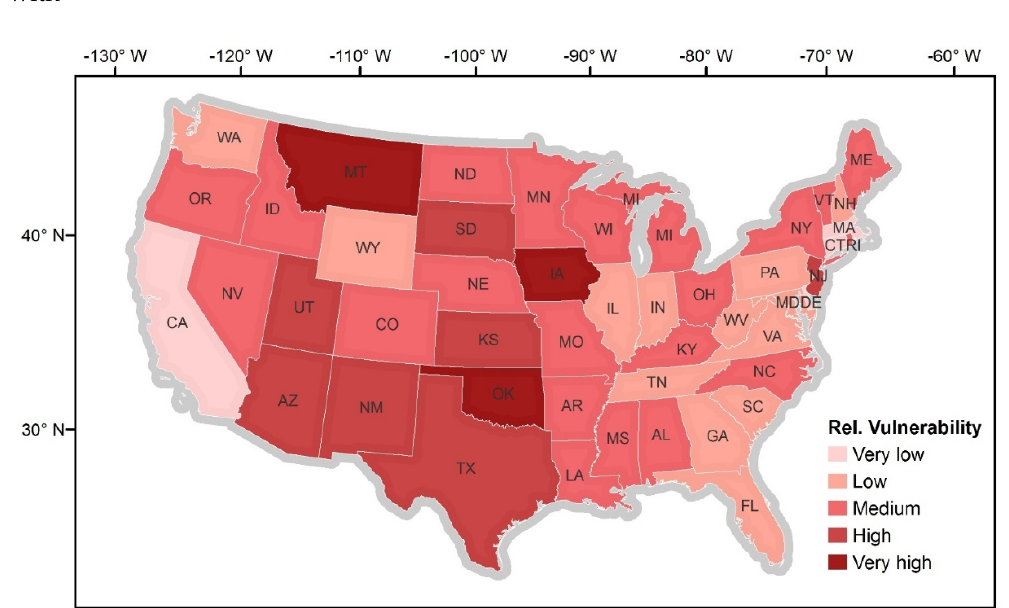
Figure 4. State-wise drought vulnerability across the U.S. Only three states are found in the most vulnerable category, namely Oklahoma, Montana and Iowa. Four states are identified as having very low vulnerability to drought, of which Delaware is the least vulnerable.